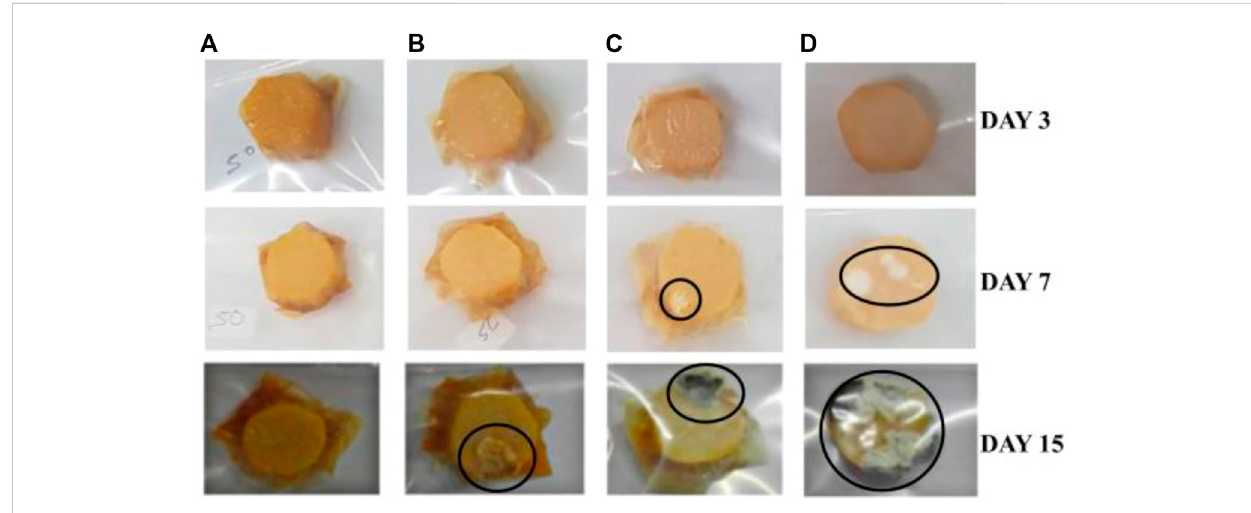
FIGURE 9 Shelf-life extension of packed food wrapped with chitosan-poly (vinyl) alcohol fi lm forti fi ed with MNPs. Where (A – D) represent the different concentrationsofchitosanandpoly(vinyl)alcoholusedinthefabricationofthe fi lm.Reproducedwithpermission(Nwaboretal.,2020).Copyright2020, Elsevier.